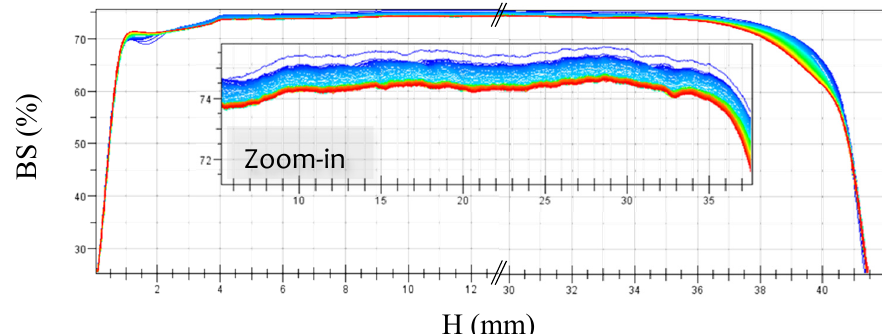
Figure 7. Macroscopic aspects of the SBR latexes synthesized based on the recipe in Table 2, using HD or ODA as the hydrophobe or without hydrophobe.